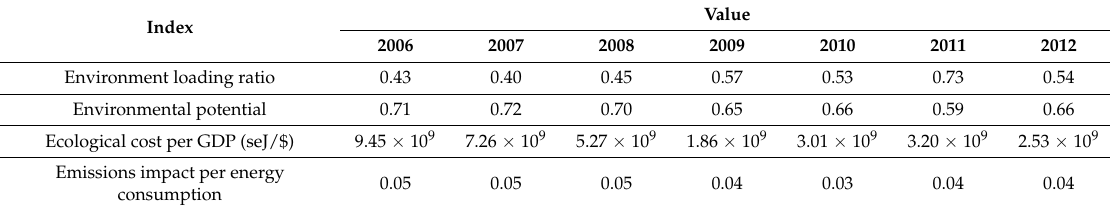
Table 6. Emergy-based indicators calculated for